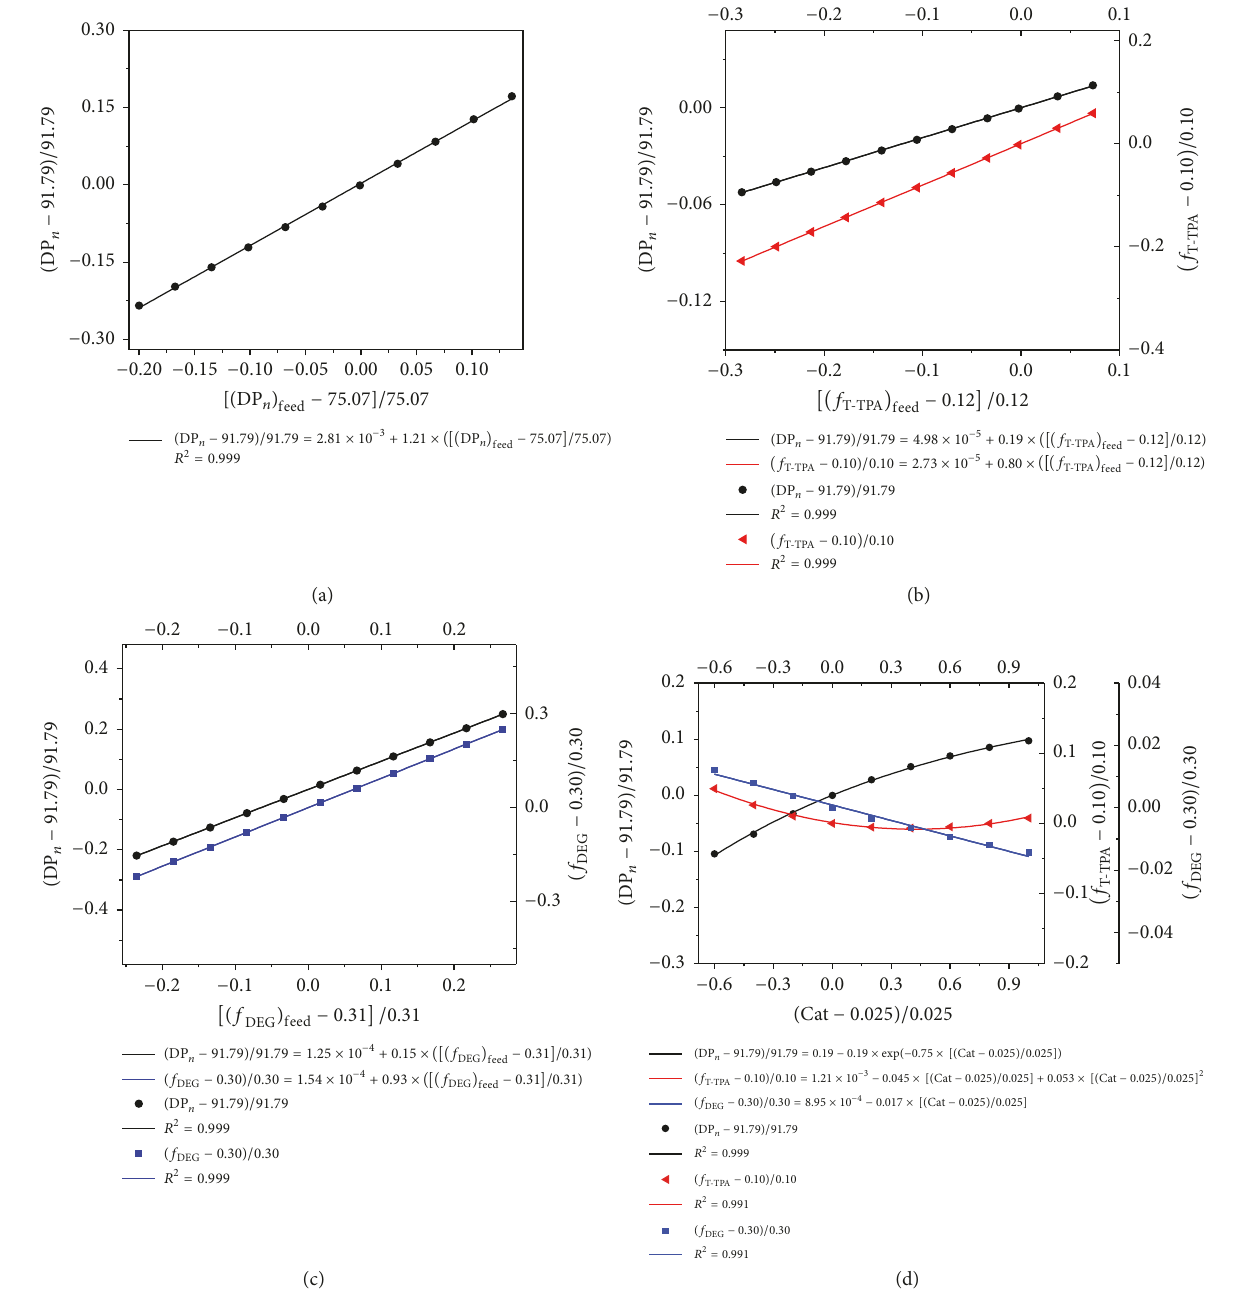
Figure 4: Effects of feed material properties on quality indexes of liquid polymerization product. (a) Initial degree of polymerization, (b) initial carboxyl end group content, (c) initial diethylene glycol content, and (d) catalyst